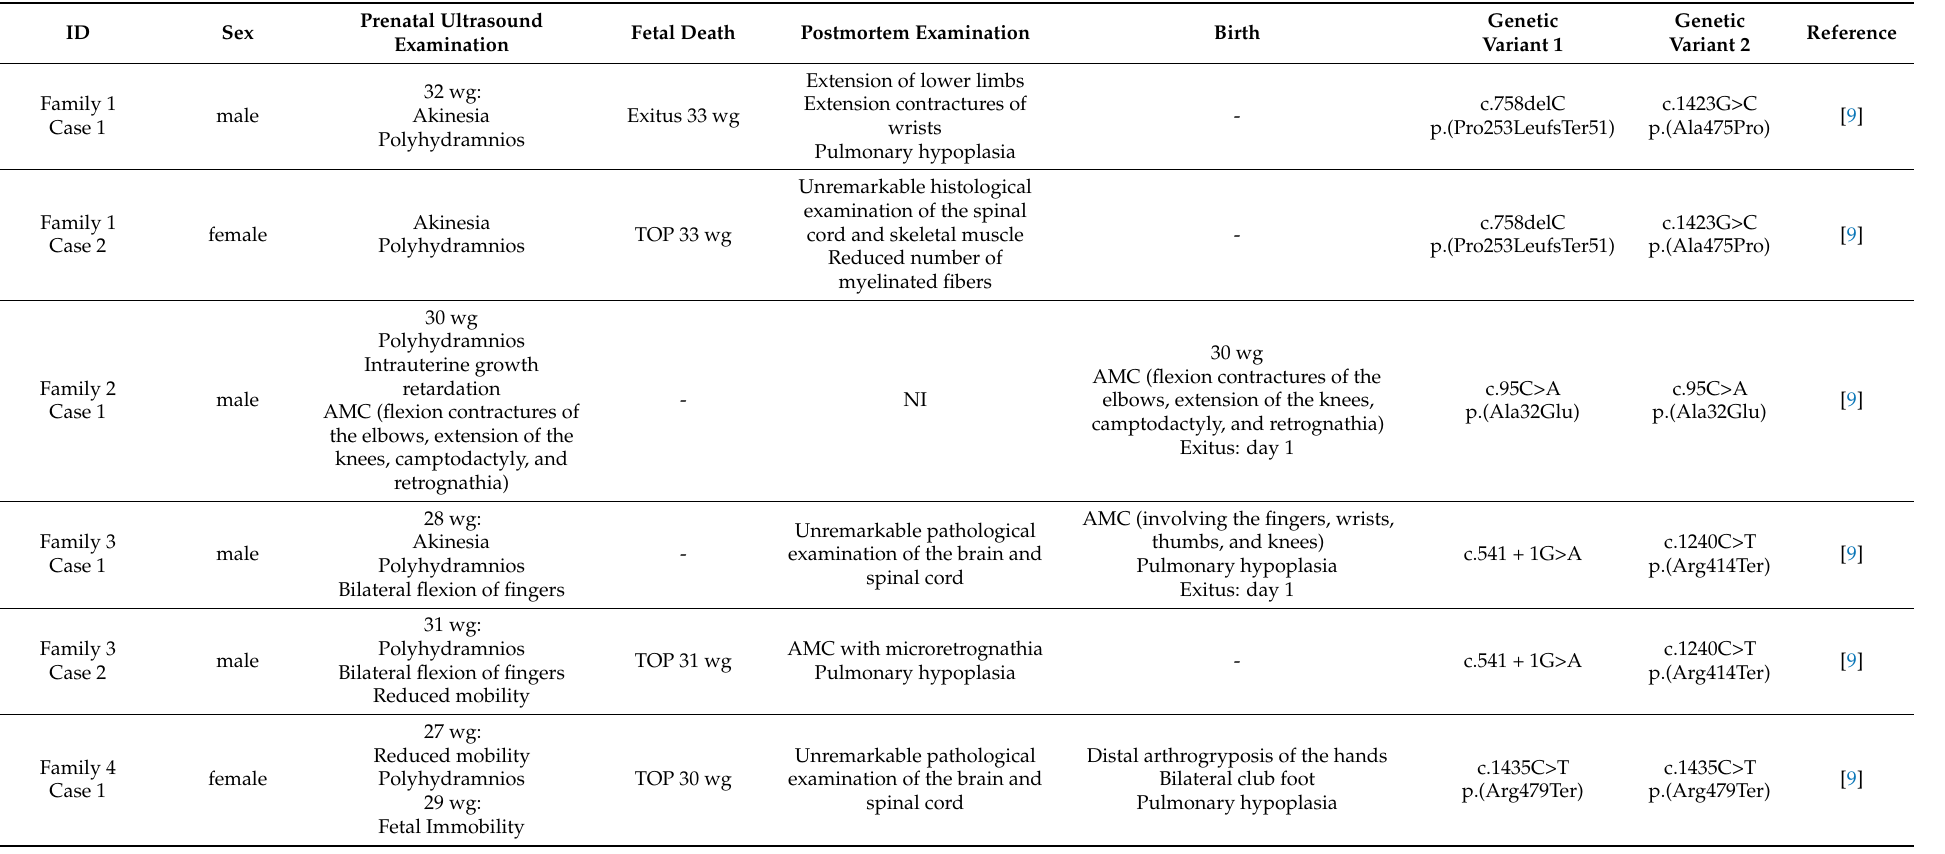
Table 1. Clinical characteristics of cases with biallelic GLDN variants and arthrogryposis multiplex congenita